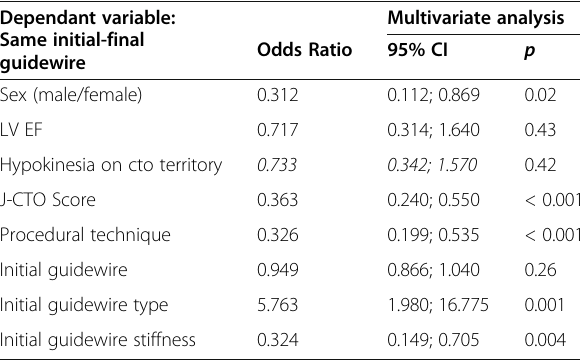
Table 8 Multivariate logistic regression analysis to reveal the determinants of the crossability of initial choice guidewire Dependant variable: Same